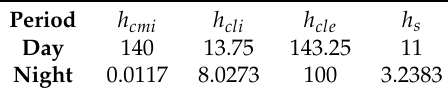
Table 2. Heat transfer coefficients